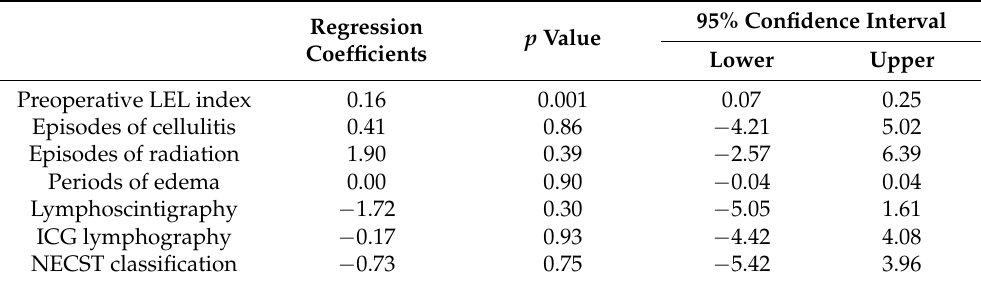
Table 3. The multiple regression analysis of the factors related to lymphedema improvement after all surgical